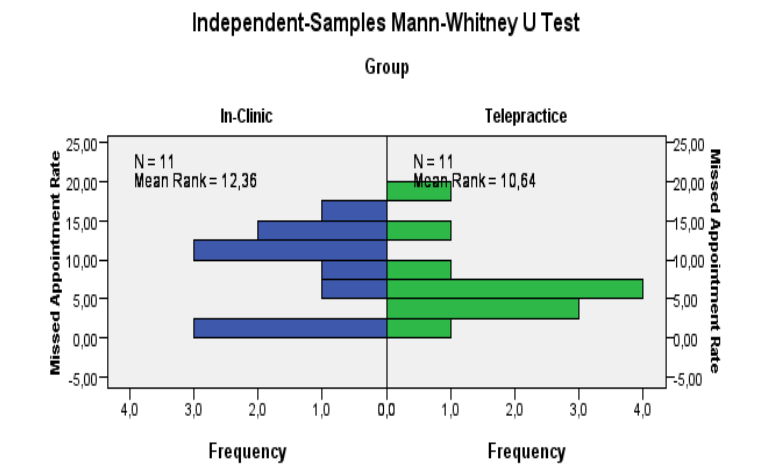
Comparison of Missed Appointment Rate for In-Clinic and Telepractice